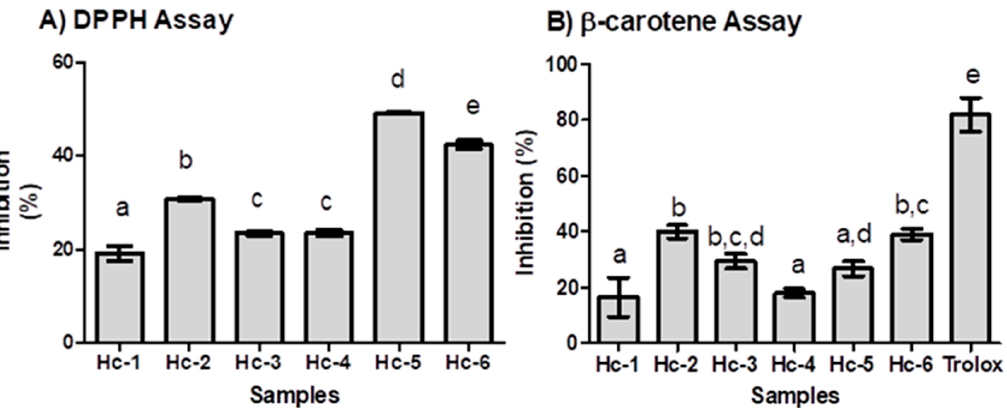
Figure 6. Antioxidant activity of essential oils of Hyptis crenata: ( A ) DPPH Assay ( B ) β -carotene assay. Values with the same letters in the bars (a, b, c, d or e) do not differ statistically in the Tukey test ( p > 0.05).